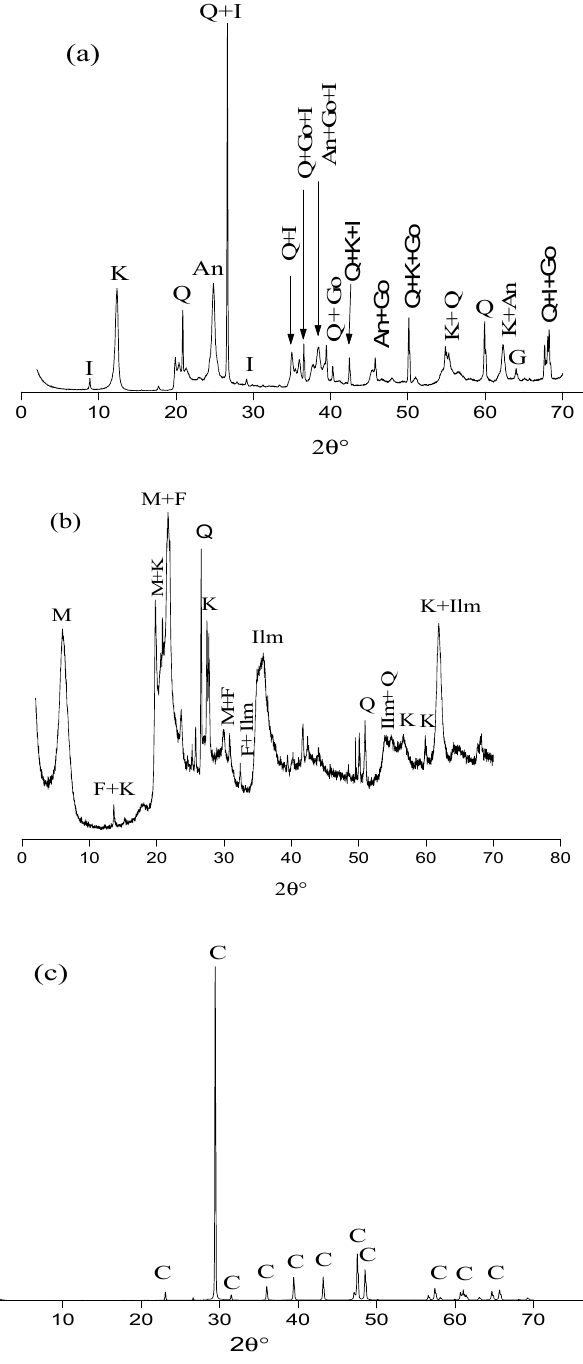
Figure 1. XRD diffraction patterns of the raw materials ( a ) kaolin, ( b ) bentonite, and ( c ) limestone. M: montmorillonite; I: illite; Q: quartz; C: calcite; K: kaolinite; F: feldspath; Ilm: ilmenite; An: anatase; Go: